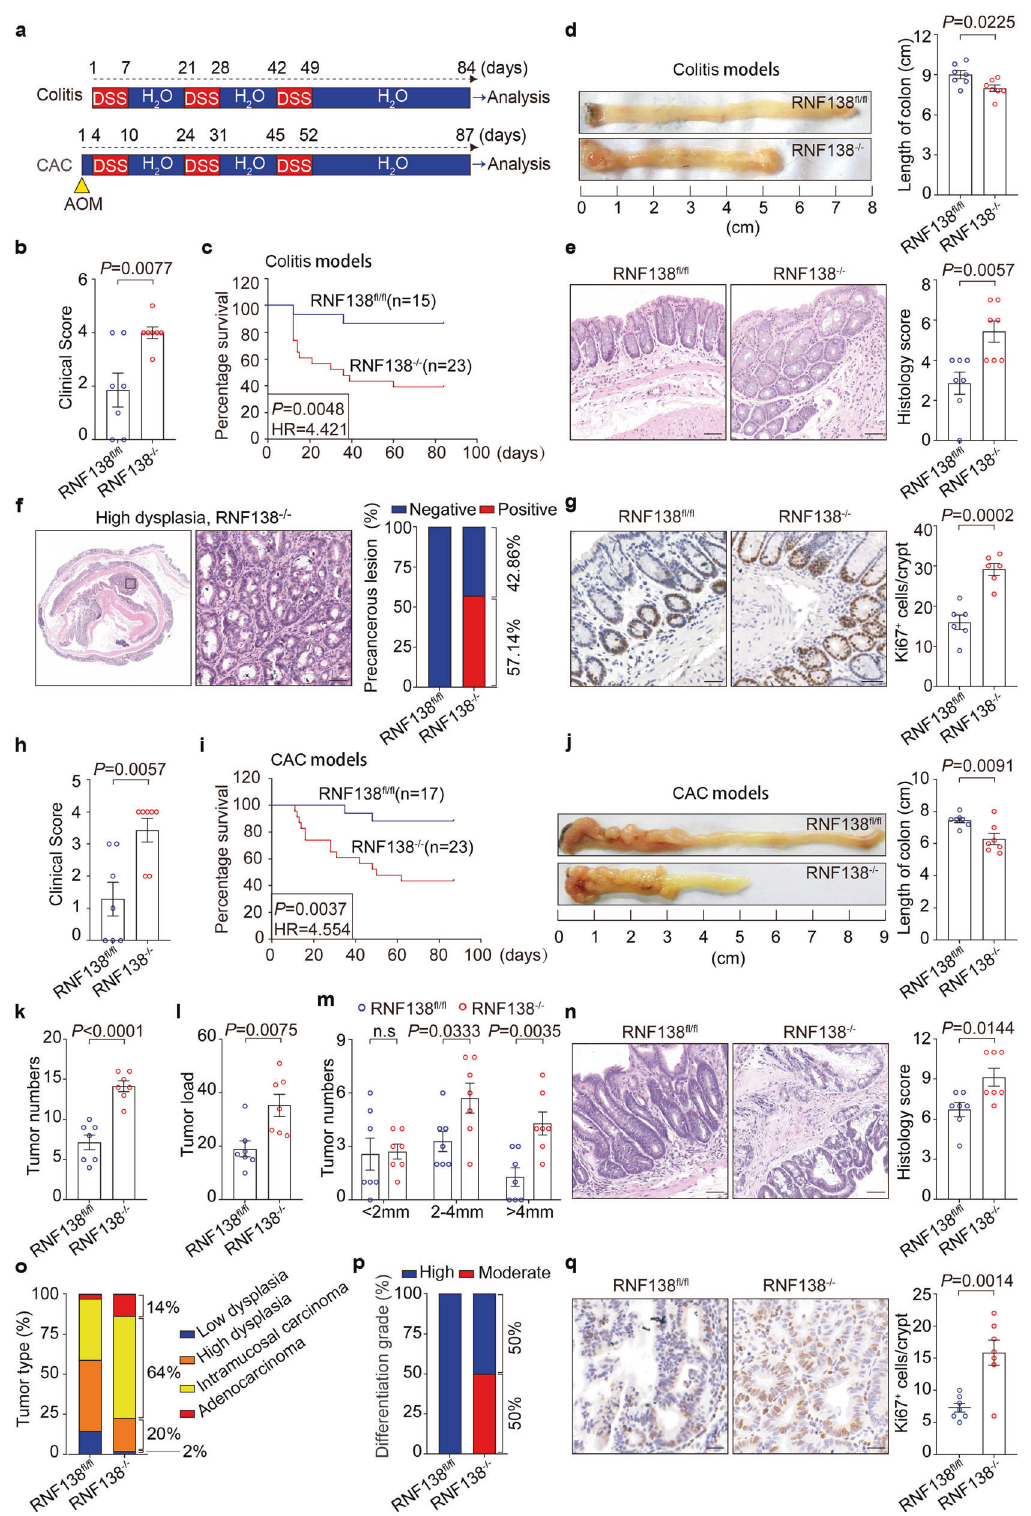
interfering RNA (siRNA). In both HCT116 and RKO cells, upon RNF138 RNA i , p65 levels were moderately increased though with signi fi cant increase in the phosphorylation of p65 (pp65) (Supplementary Fig. S5e), consistent with results observed when disrupting RNF138 by CRISPR-Cas9 (Fig. 3k). Furthermore, RNF138 Signal Transduction and Targeted Therapy (2022)